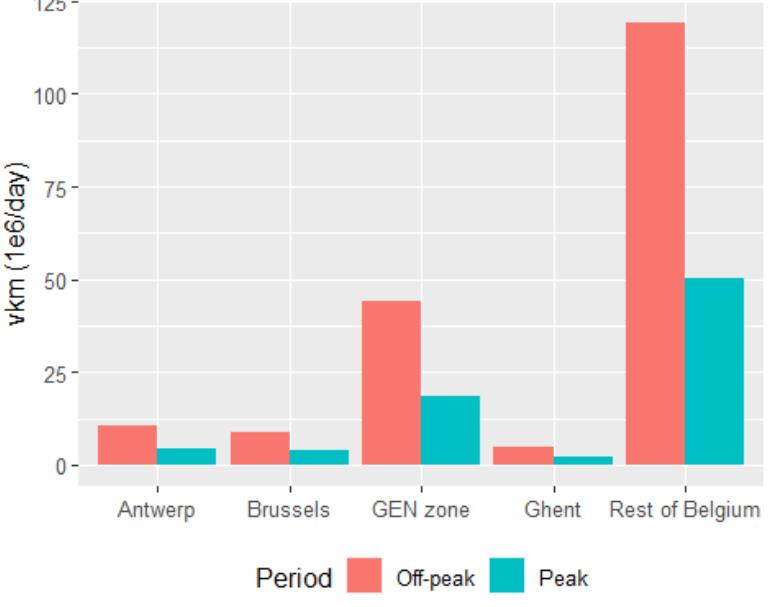
Figure 3. Vehicle kilometres in the reference scenario (per GEO